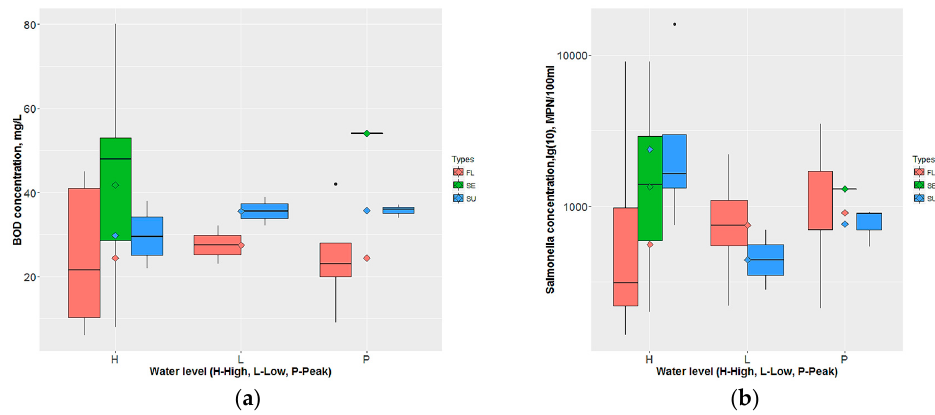
Figure 5. Box plot of temporal variation of BOD ( a ) and Salmonella ( b ) during the flood event (High: rising water levels, low: receding water levels, see more detail in supplement S2; SU: Open/Surface water, SE: Sewer water, FL: Flood water; the diamond symbols representing average values).